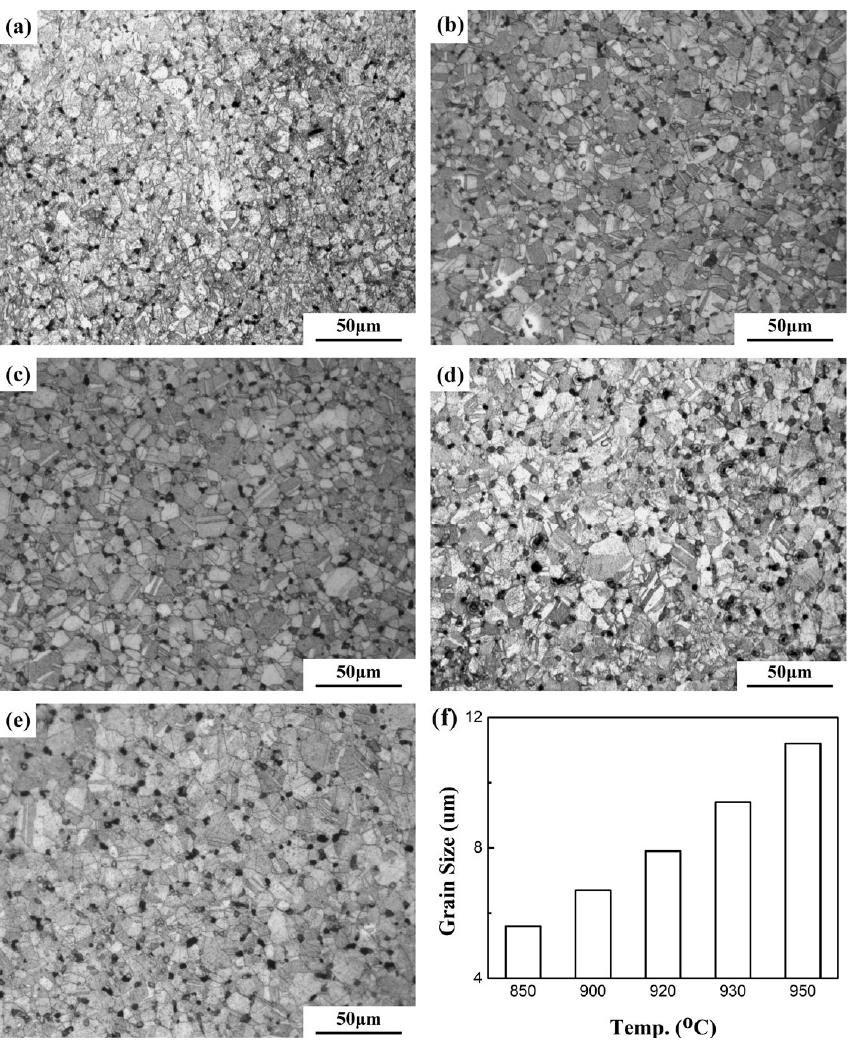
Figure 4. Optical micrographs of etched Cu samples sintered at ( a ) 850 °C, ( b ) 900 °C, ( c ) 920 °C, ( d ) 930 °C, ( e ) 950 °C, and ( f ) grain size of the samples versus sintering temperature.